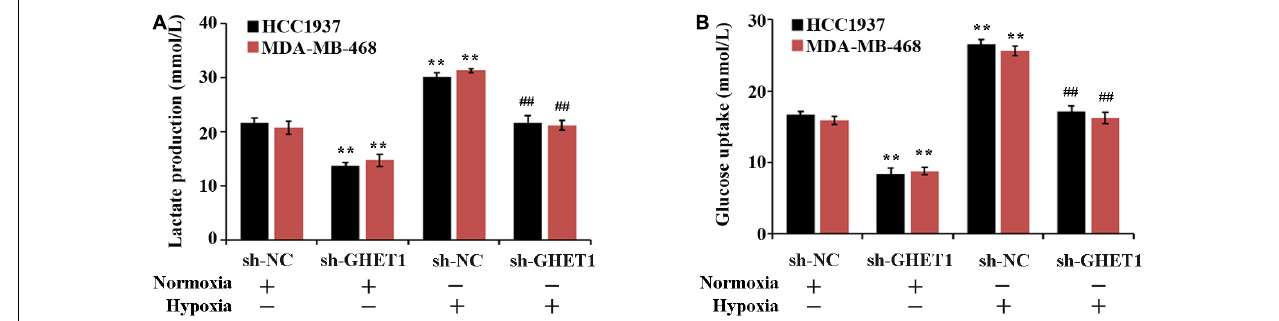
FIGURE 3 | Low expression of lncRNA GHET1 can inhibit hypoxia-induced glycolysis o f TNBC cells. MDA-MB-468 and HCC1937 cells were transfected with sh-GHET1 or control plasmid under normoxia and hypoxia conditions. The lactate production (A) and glucose uptake (B) were measured. ** P < 0.01 vs. Normoxia + sh-NC group; ## P < 0.01 vs. Hypoxia + sh-NC group.